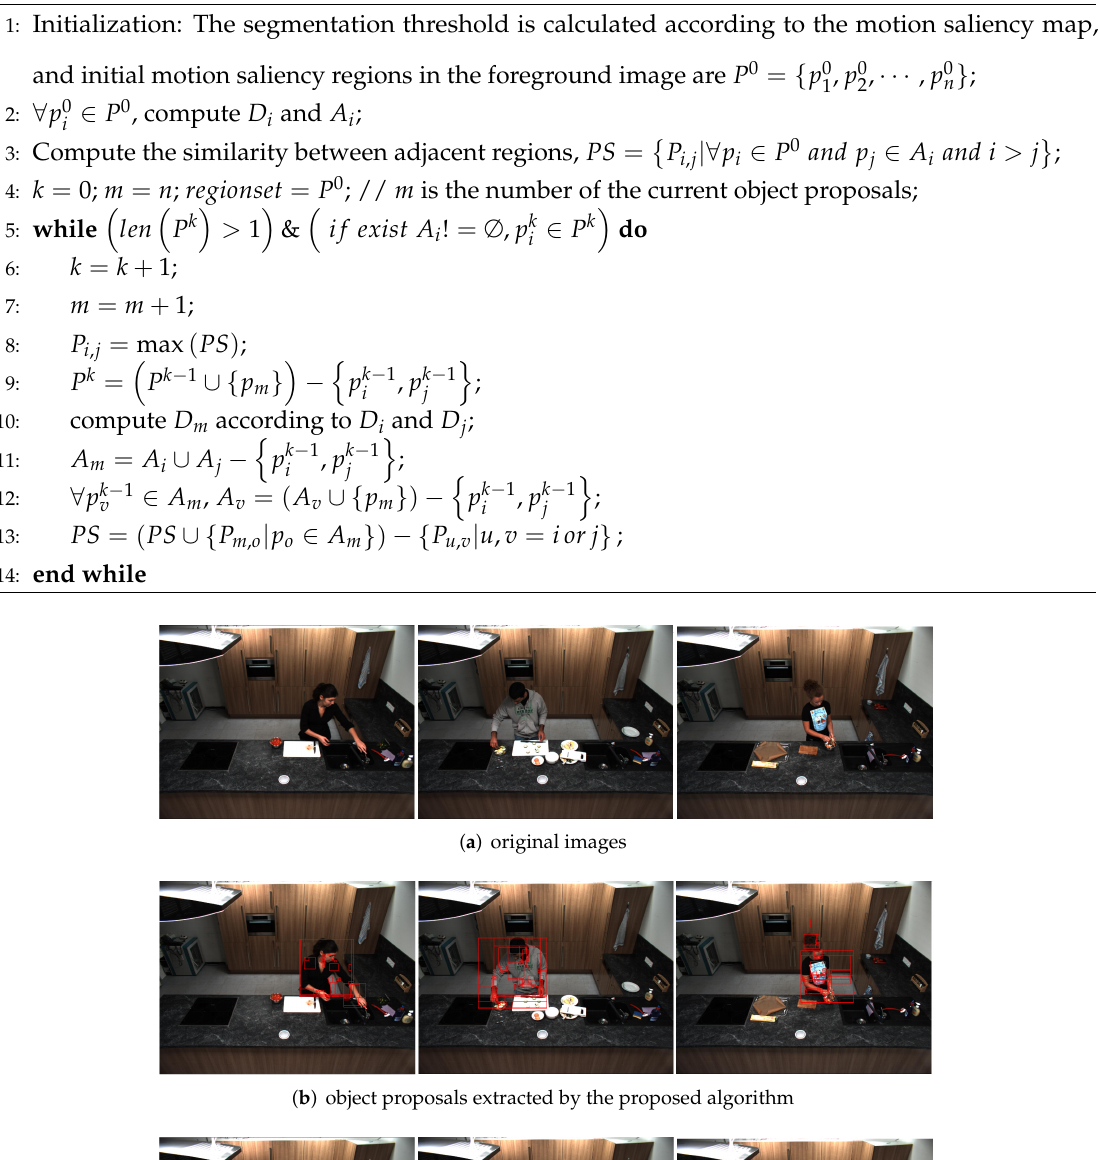
Algorithm 1 Object proposal generation algorithm.